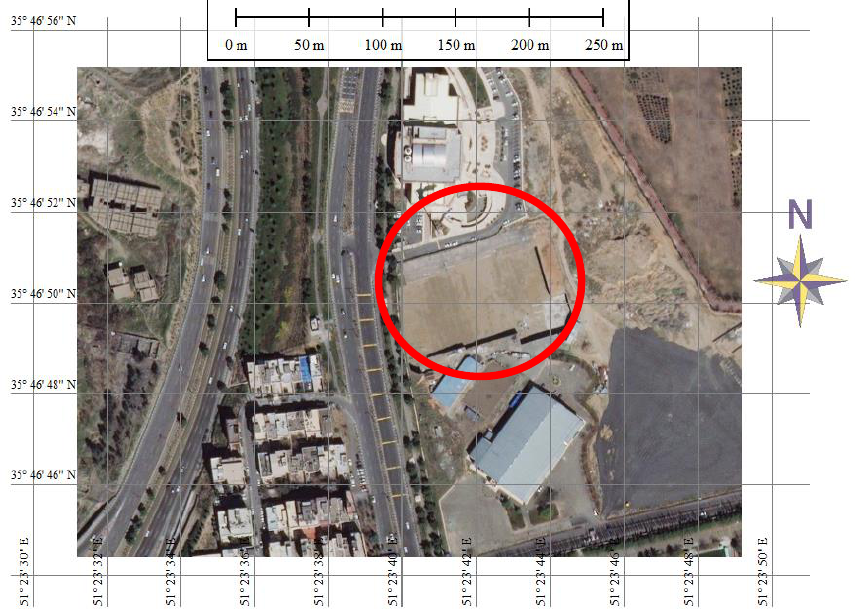
Figure 9. Introduction and location of the studied project.